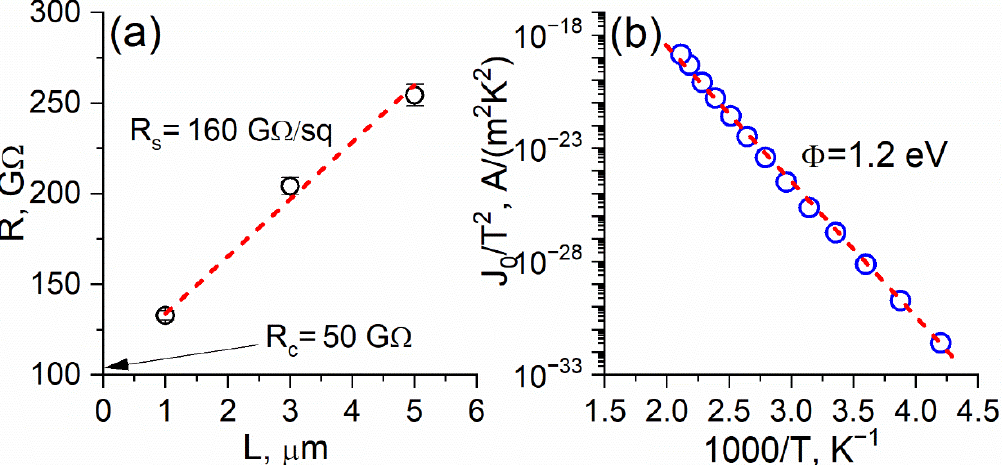
Figure 7. ( a ) Sulfurized MoS 2 -based FET resistivity as a function of channel length; ( b ) Arrhenius plot of J 0 /T 2 as a function of 1/T used for calculating the effective Schottky barrier height using the thermionic emission model.